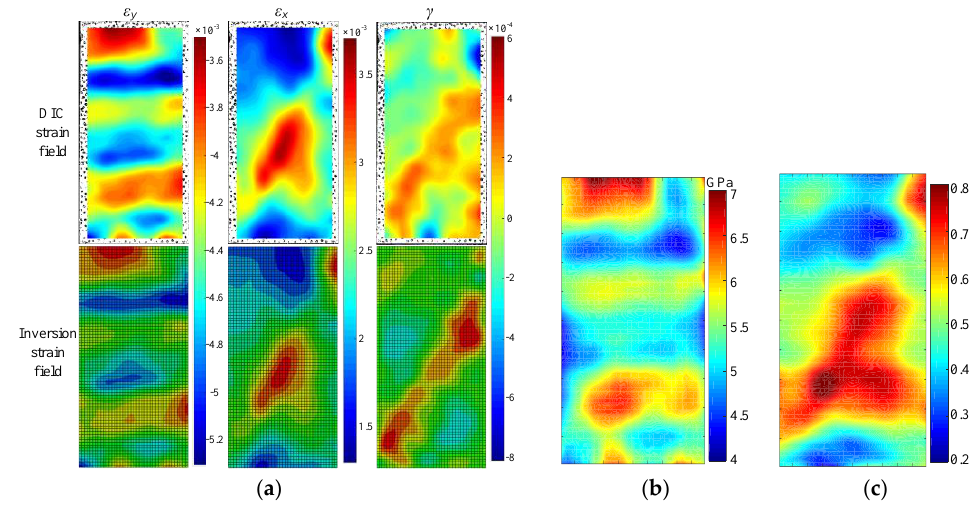
Figure 7. Testing system.